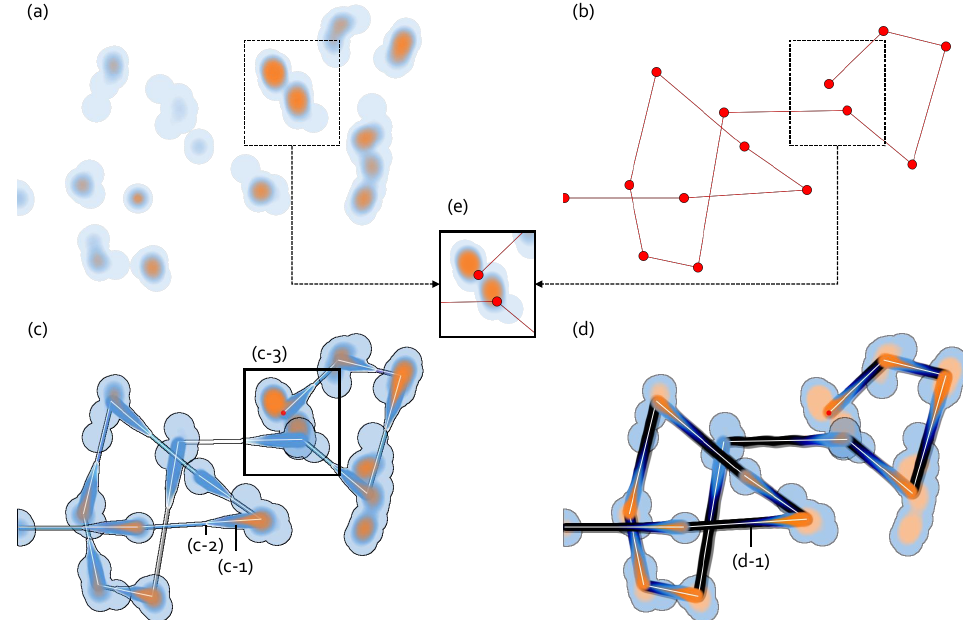
Figure 1. Gaze visualizations. ( a , b ) The heatmap and scanpath visualization. ( c ) Our abstract gaze movement visualization. ( d ) A gaze data visualization proposed by Yoo et al. [6]. ( e ) presents the visualization of combining the heatmap and scanpath visualizations. ( c-1 ) and ( d-1 ) shows an example of eye movements and ( c-2 ) indicates the tapering on the path for the direction. ( c-3 ) includes complicated eye movement patterns that correspond to ( e